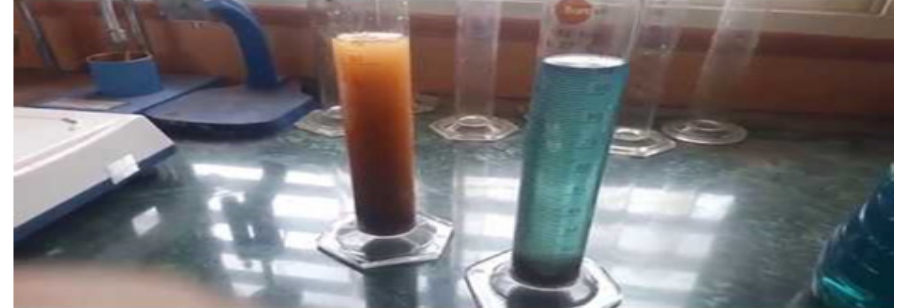
Materials 2022 , 15 , x FOR PEER REVIEW Figure 1. Free swelling test apparatus. Figure 1. Free swelling test apparatus.